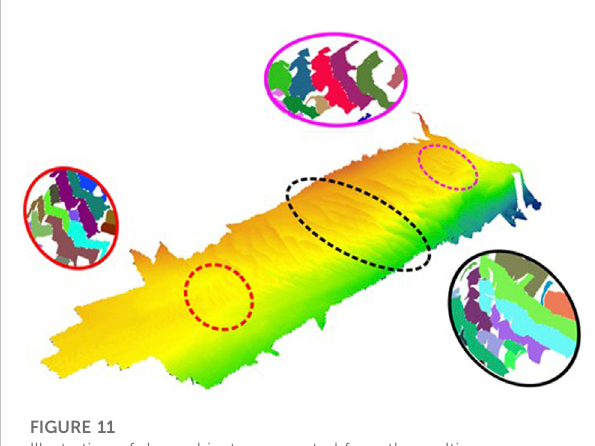
FIGURE 11 Illustration of dune objects segmented from the multisource DBM. The individual dune objects are identi fi ed by a unique random color in the ellipses which indicate their location on the sea fl oor